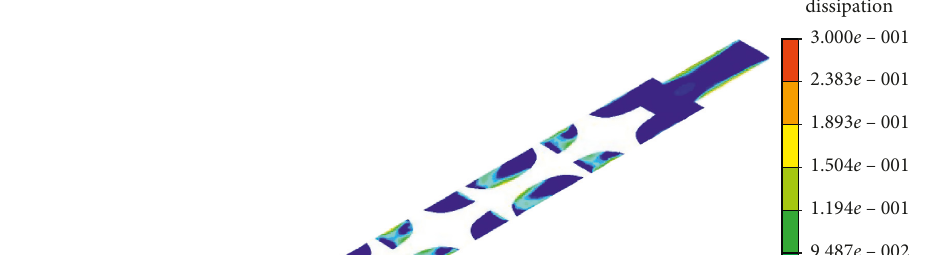
L obtained by the use of Kenics: (a) Re ( )